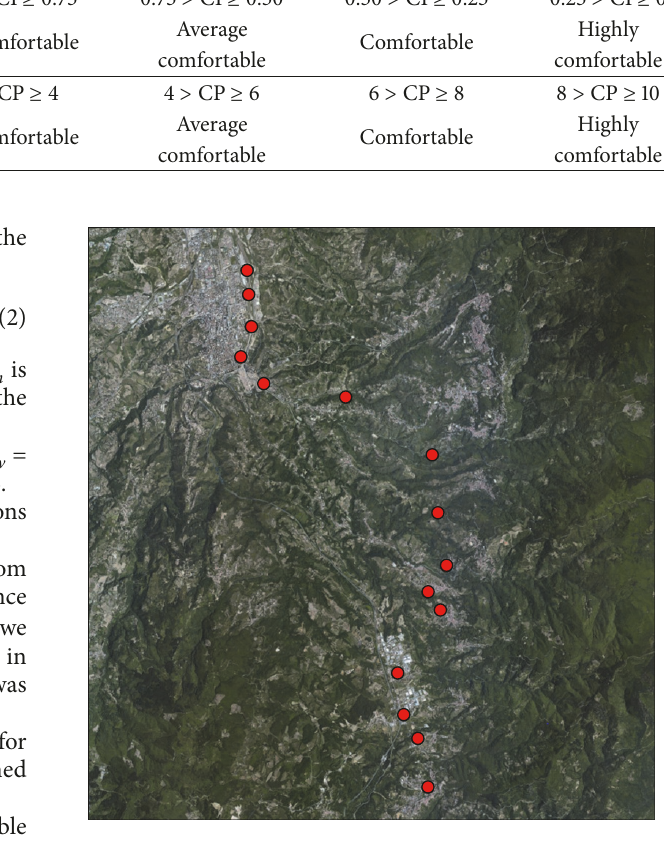
Figure 8: Test site Cosenza Vaglio